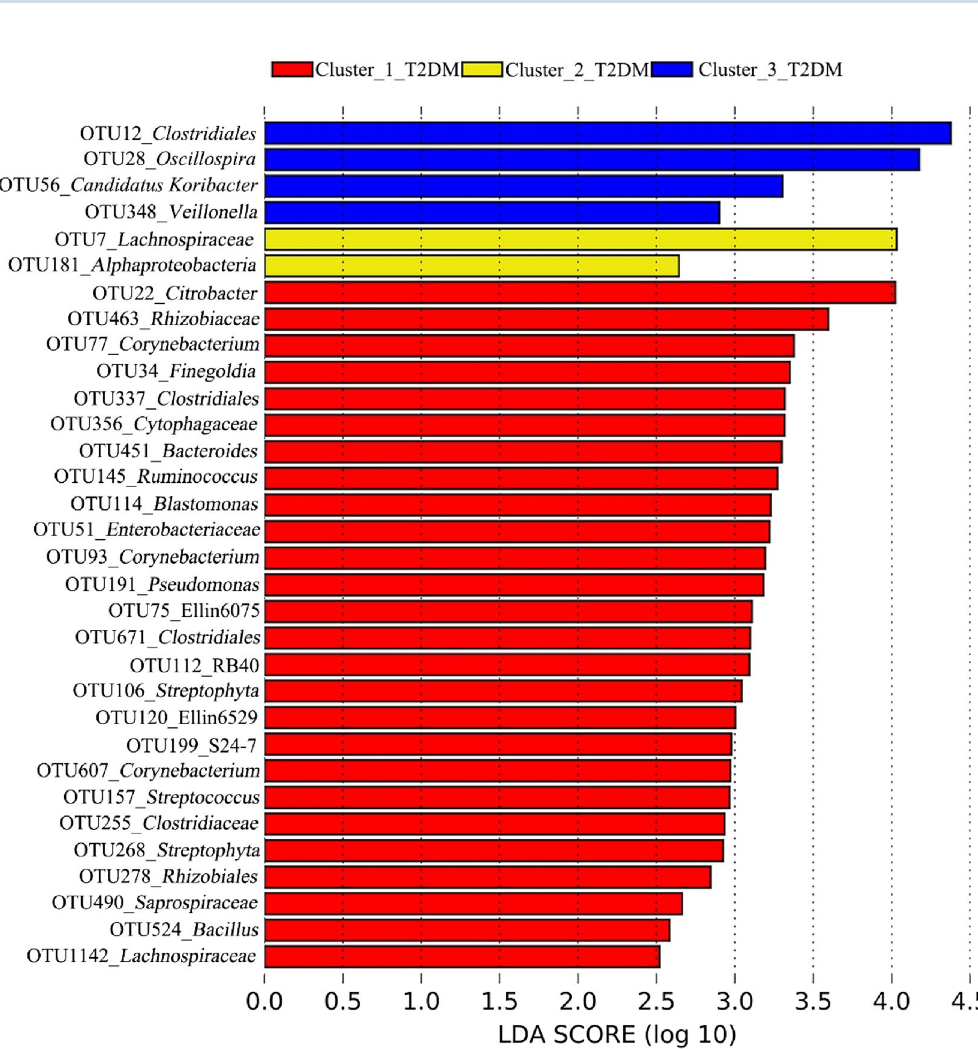
Figure 4. The phylotypes associated with each of the three clustered T2DM microbiomes determined by Linear Discriminant Analysis (LDA) Effect Size (LEfSe). Note: the analysis was done on the Huttenhower online software (http://hutte nhowe r.sph.harva rd.edu/galax